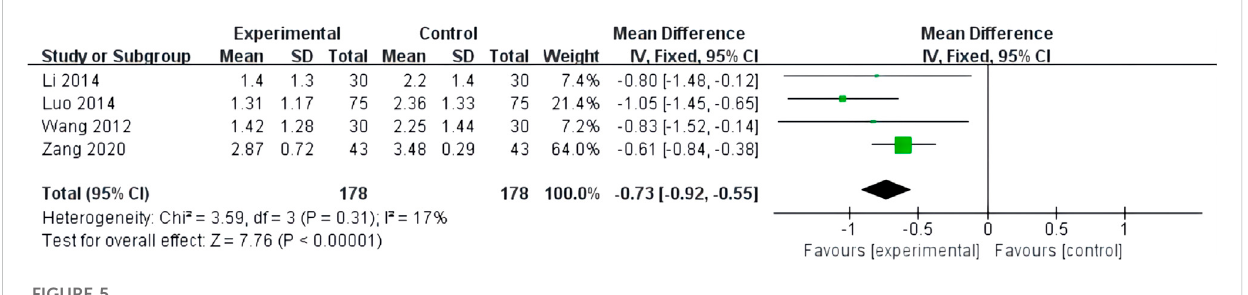
FIGURE 5 Forest plot of frequency of Duration of angina pectoris.